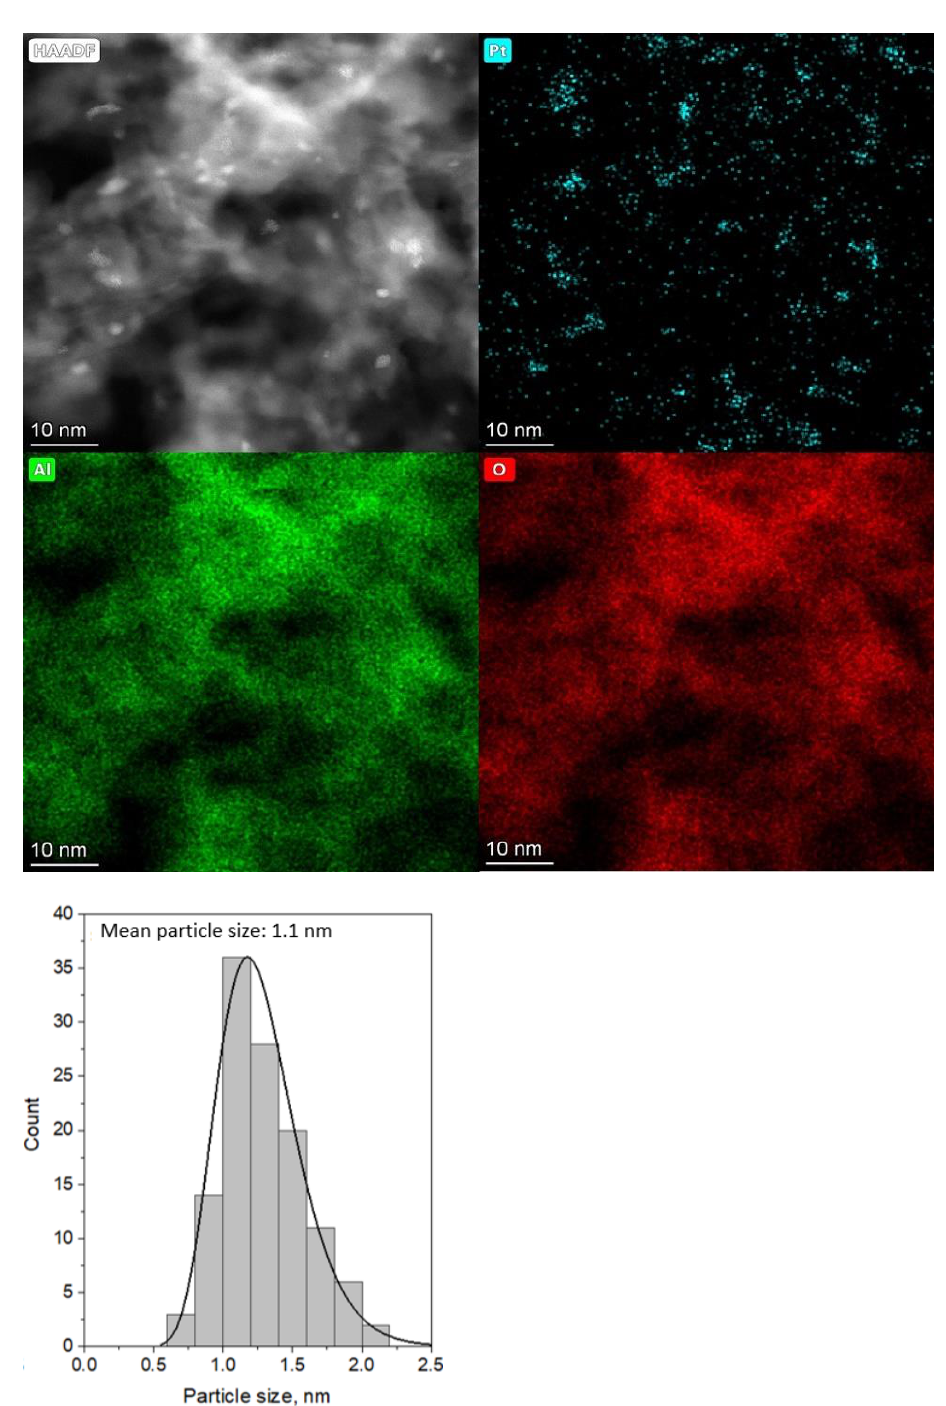
Figure 6. HAADF–STEM imaging, elemental EDS mapping images and particle size distribution from CAT-A catalyst prepared using SCD/scCO 2 .